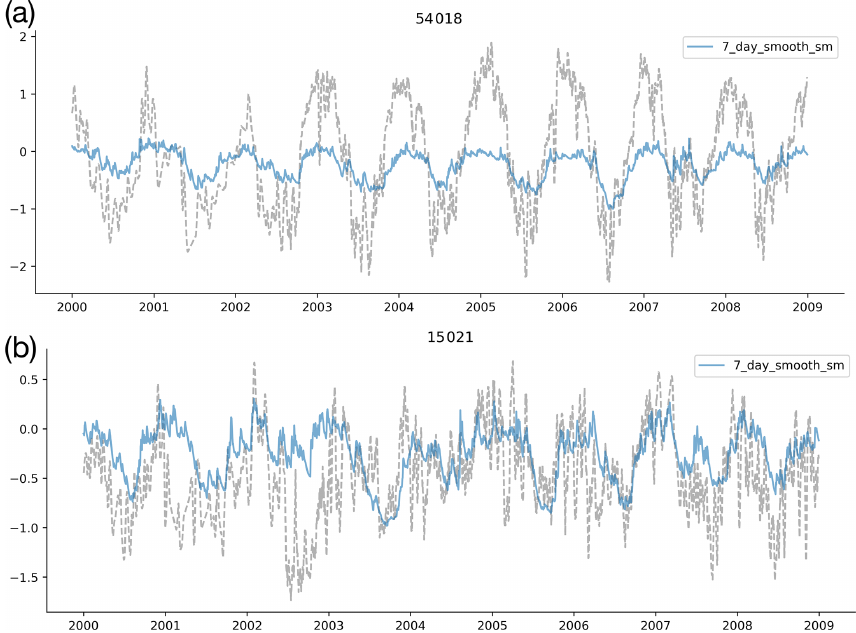
Figure B2. Time series of probe predictions (coloured lines) compared with the target variables (grey dotted lines). We show two catchments here, 54018 and 15021 for the ESA CCI Soil Moisture product, which is the same as Fig.